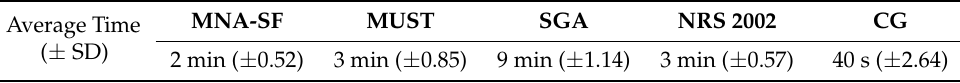
Table 3. Average time of each nutritional tool assessment spent with one subject.